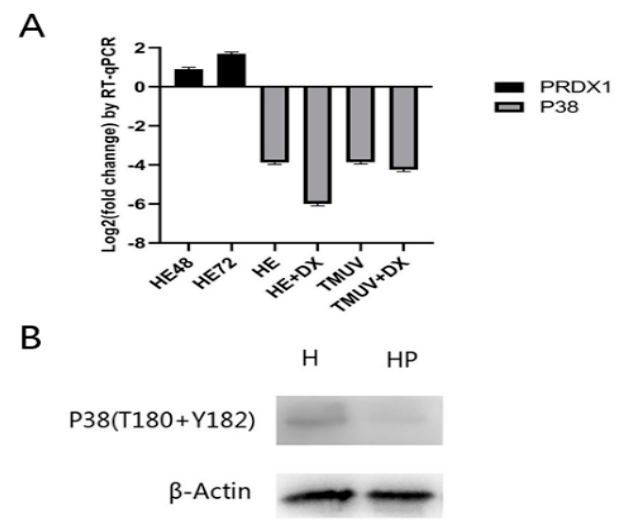
Figure 9. Analysis of quantitative polymerase chain reaction (PCR) and phosphorylation level of p38. ( A ) Quantitative PCR analysis of PRDX1 and p38. X-axis: HE48 and HE72, HELICc transfected 48 and 72 h; HE, HELICc transfected 72 h; HE + DX, PRDX1 and HELICc co- transfected 72 h; TMUV, DTMUV infection; TMUV + DX, DTMUV infection and PRDX1 transfected 72 h. Y-axis: log2(fold change) by quantitative RT-PCR. ( B ) Western blot analysis of the phosphorylation level of p38. H, HELICc transfected 72 h; HP, HELICc, and PRDX1 co- transfected 72 h; P38(T180 + Y182), Thr180, and Tyr182 phospho-p38 rabbit mAb; β -Actin: β -actin rabbit mAb.